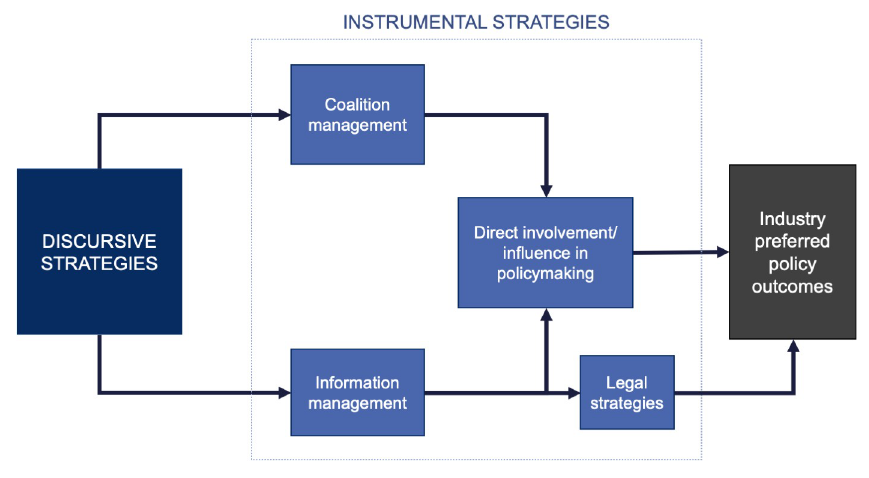
Fig 1. The Policy Dystopia Model